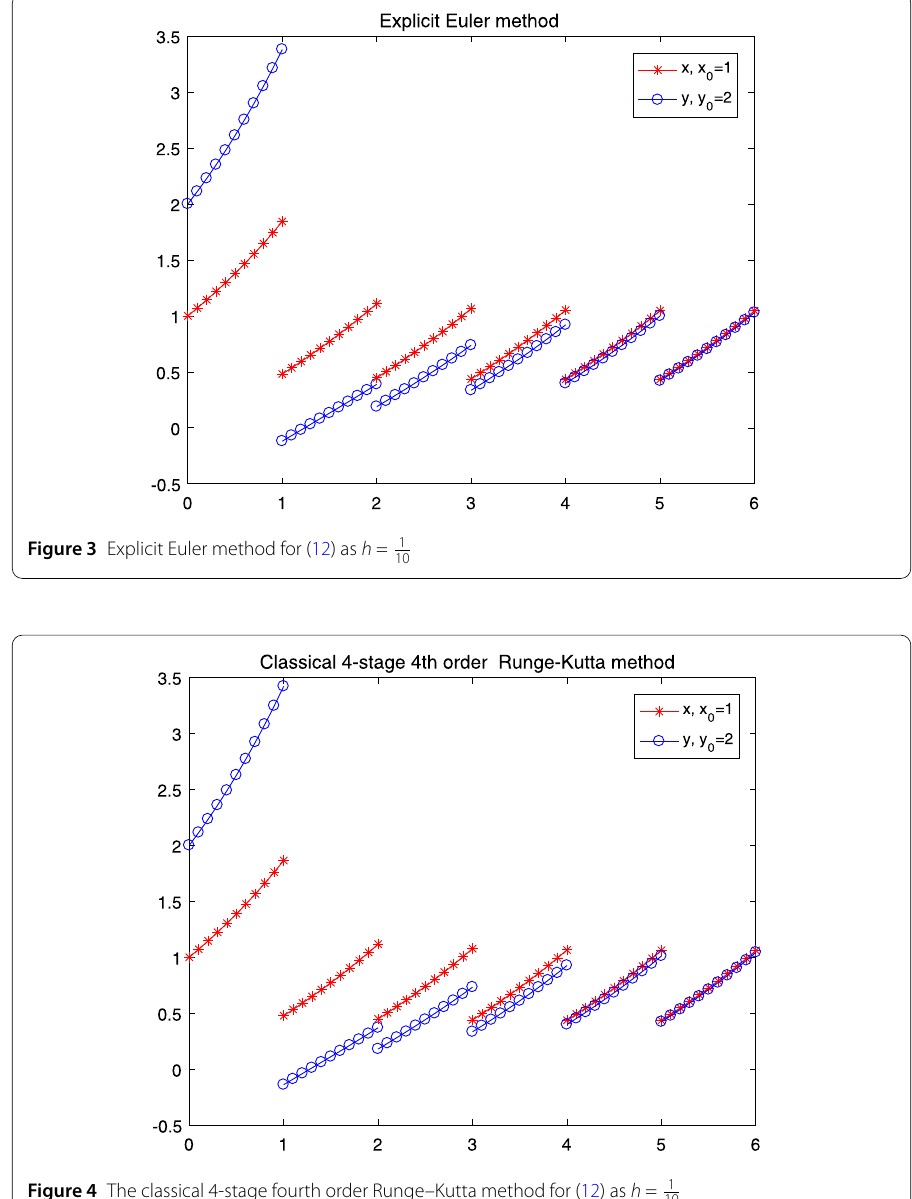
Figure 4 The classical 4-stage fourth order Runge–Kutta method for (12) as h = 1